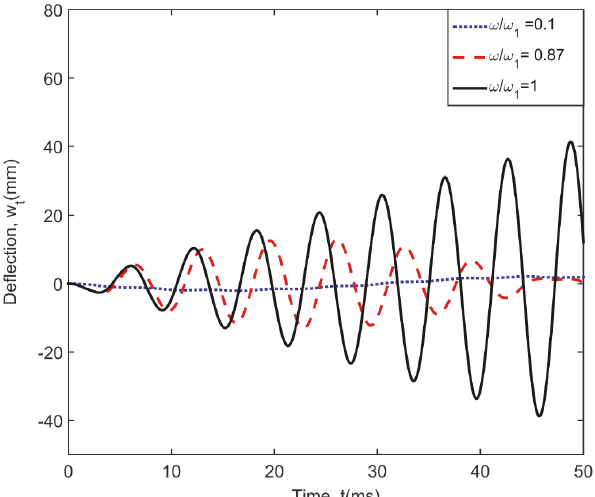
Figure 3: Tip deflection of free edge of cantilever sandwich beam ( 𝜔 𝑡 ) for applied frequency 𝜔/𝜔 1 = 0.1, 𝜔/𝜔 1 = 0.87, and 𝜔/𝜔 1 ≃ 1 [9].